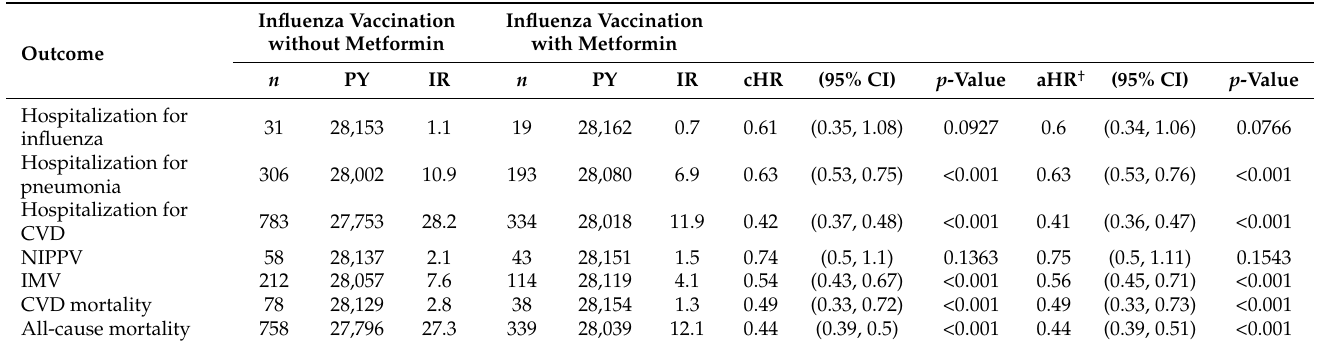
Table 3. Hazard ratios and 95 % confidence intervals for outcomes among the sampled